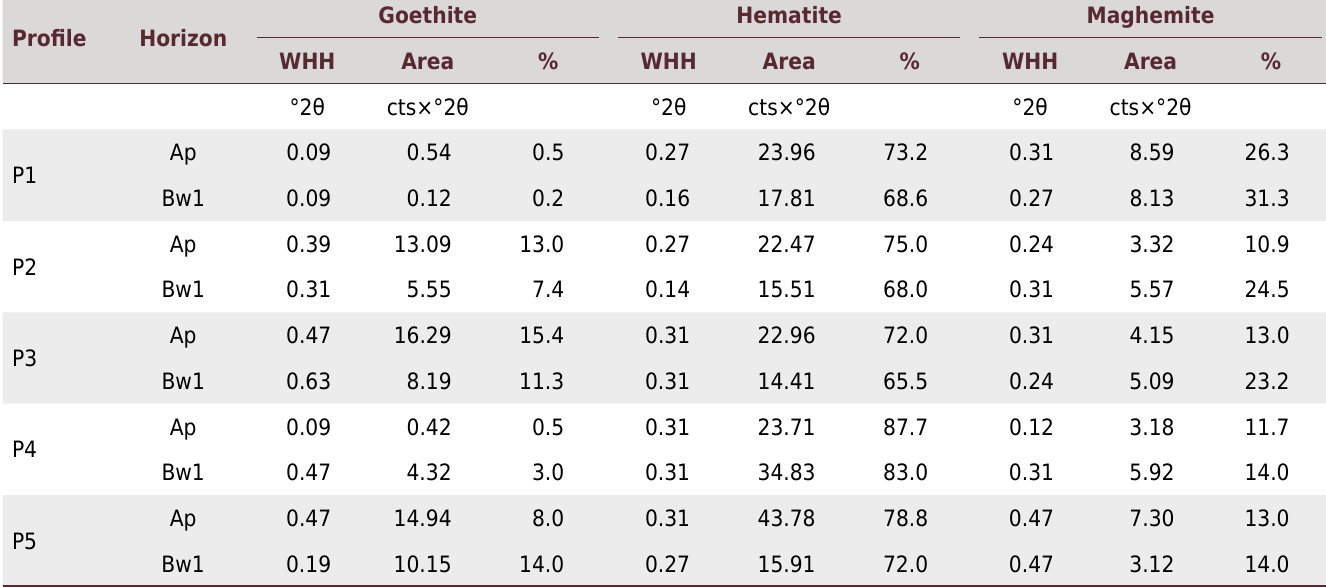
Table 2. Structural characteristics of iron oxides and hydroxides (goethite, hematite and maghemite) in the clay fraction of the Ap and Bw1 horizons of the five studied profiles